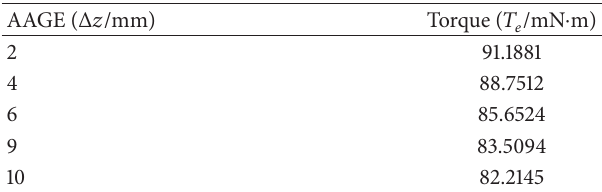
Table 5: Absolute average values of EMT due to different